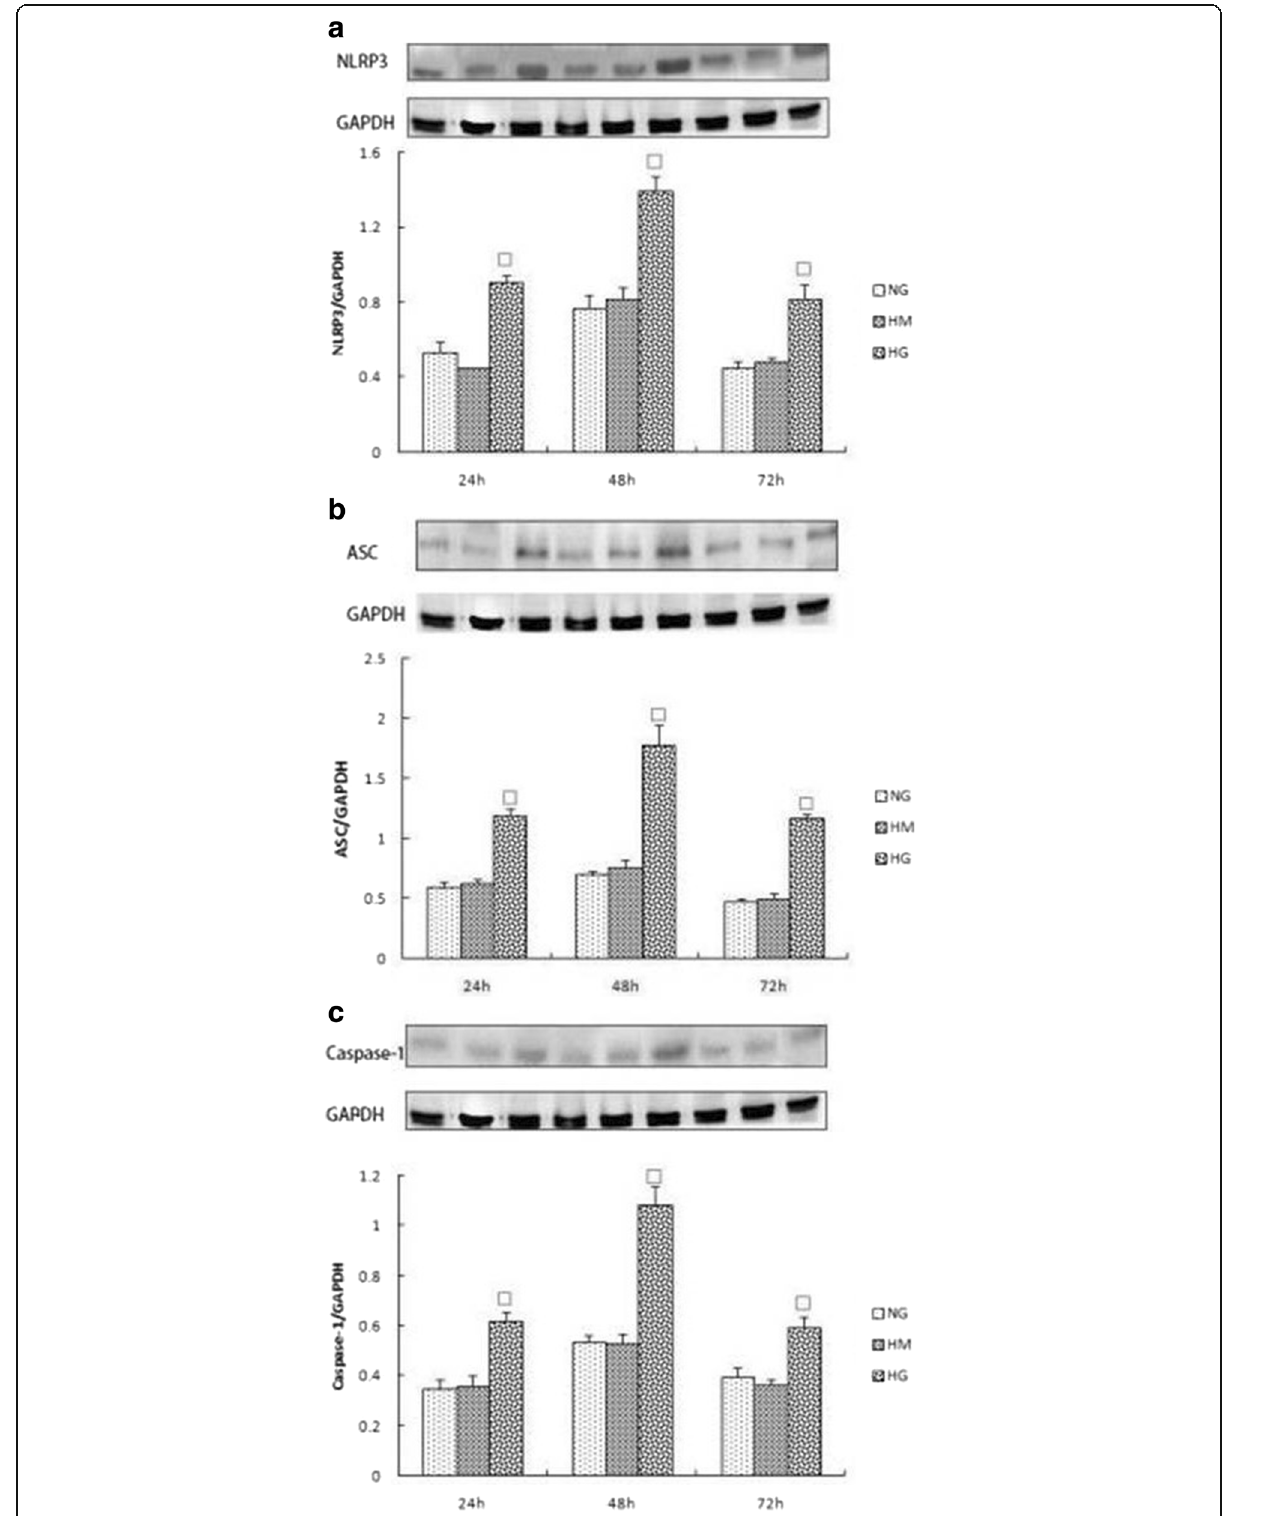
Fig. 3 a , b , c Expression of NLRP3, ASC and Caspase-1 in NG,HM,HG group at various time points (24 h,48 h,72 h).The protein was measured by western blotting.GAPDH was used as an internal loading control. NG:normal control group,HM:mannitol osmotic pressure control group,HG:high glucose group.Data are presented in mean ± SD, □ P < 0. 05 versus normal control